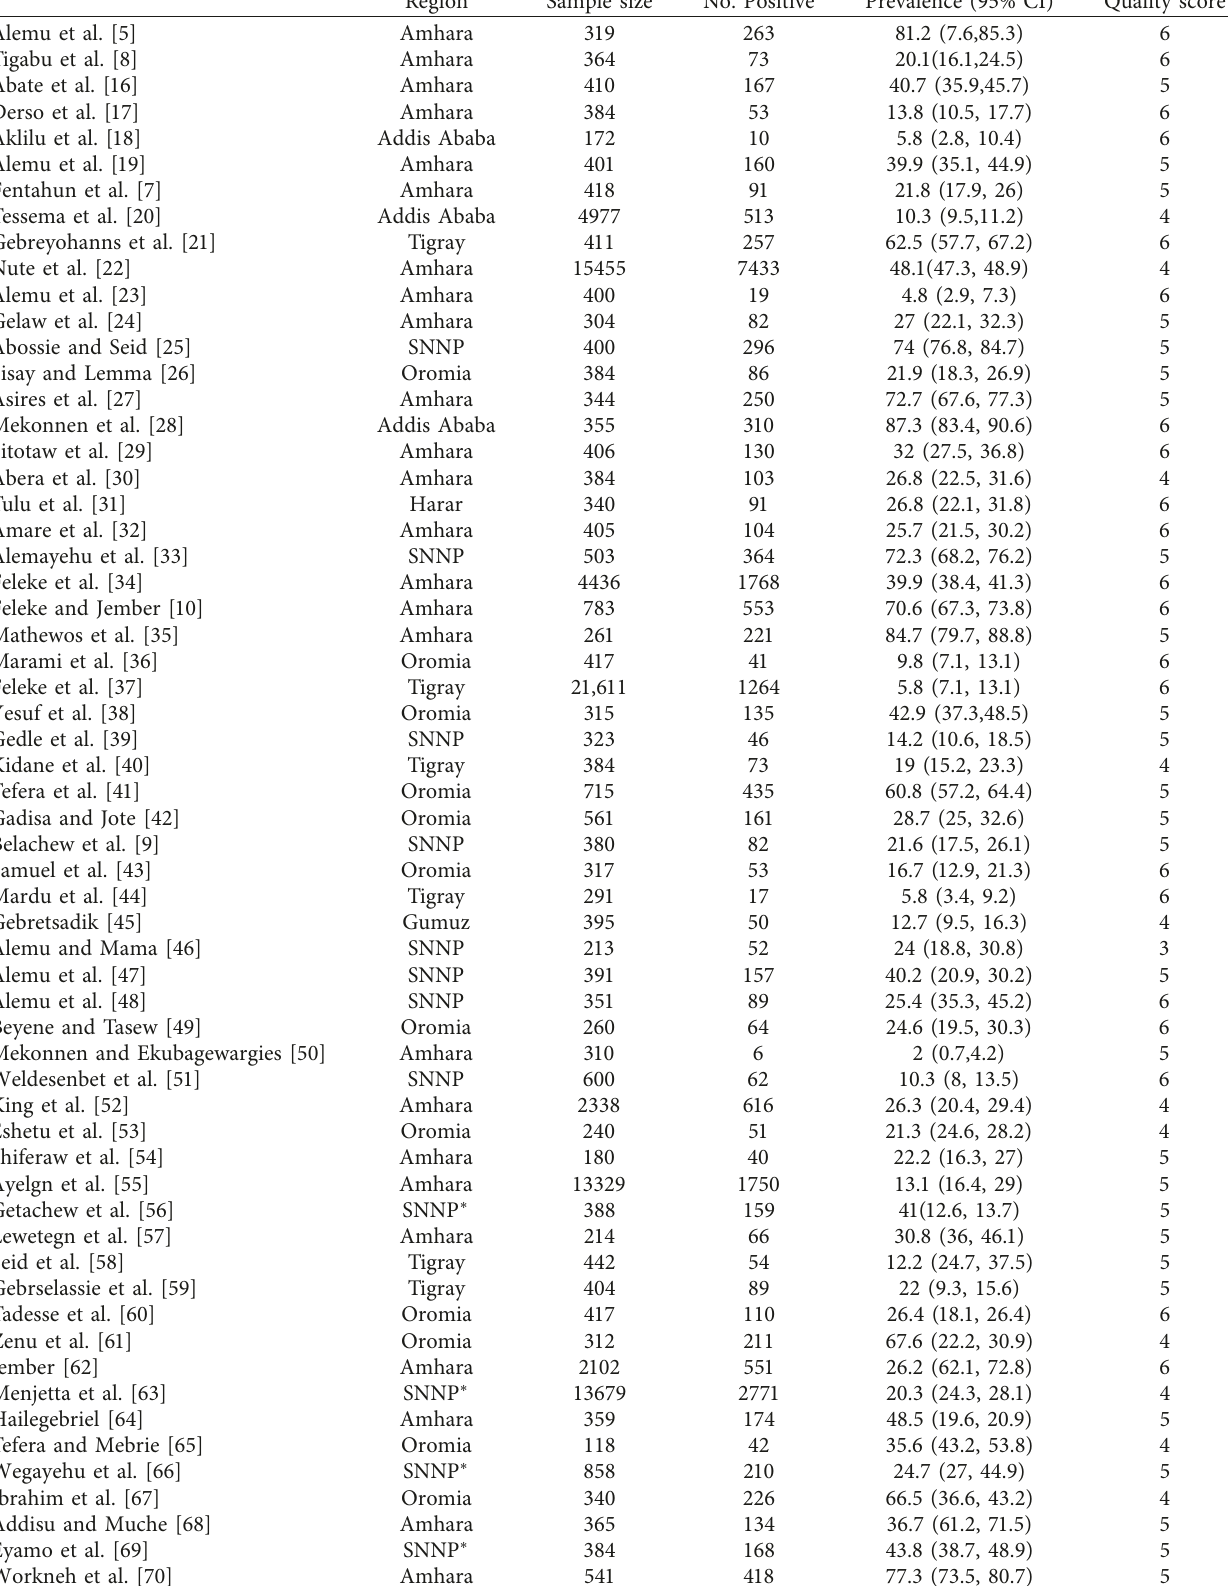
Table 1: Studies conducted in different parts of Ethiopia, their sample size, and